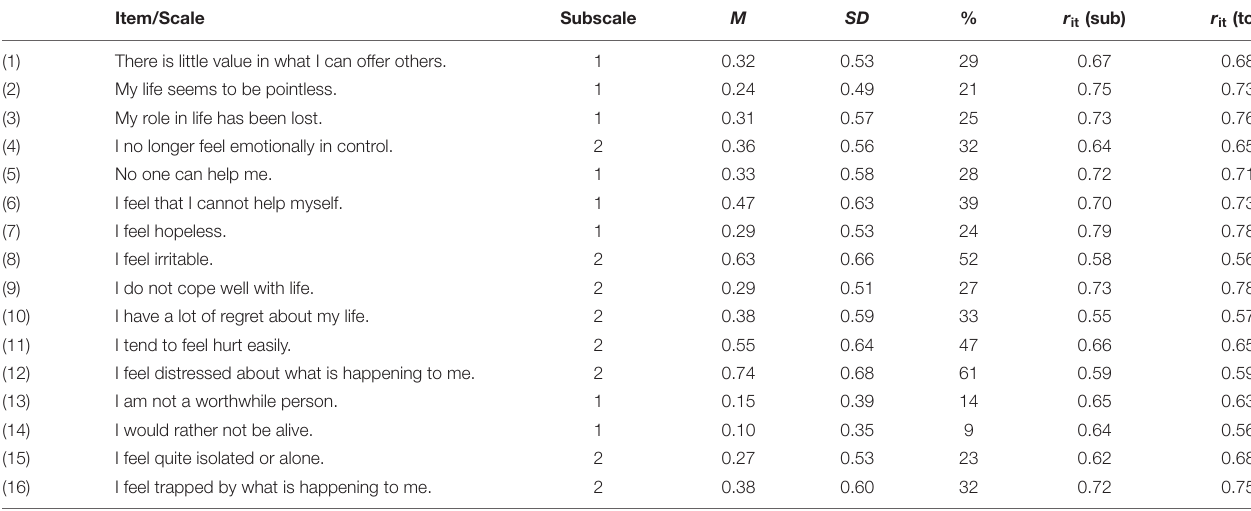
TABLE 2 | Item characteristics of the Demoralization Scale-II (DS-II). Item/Scale